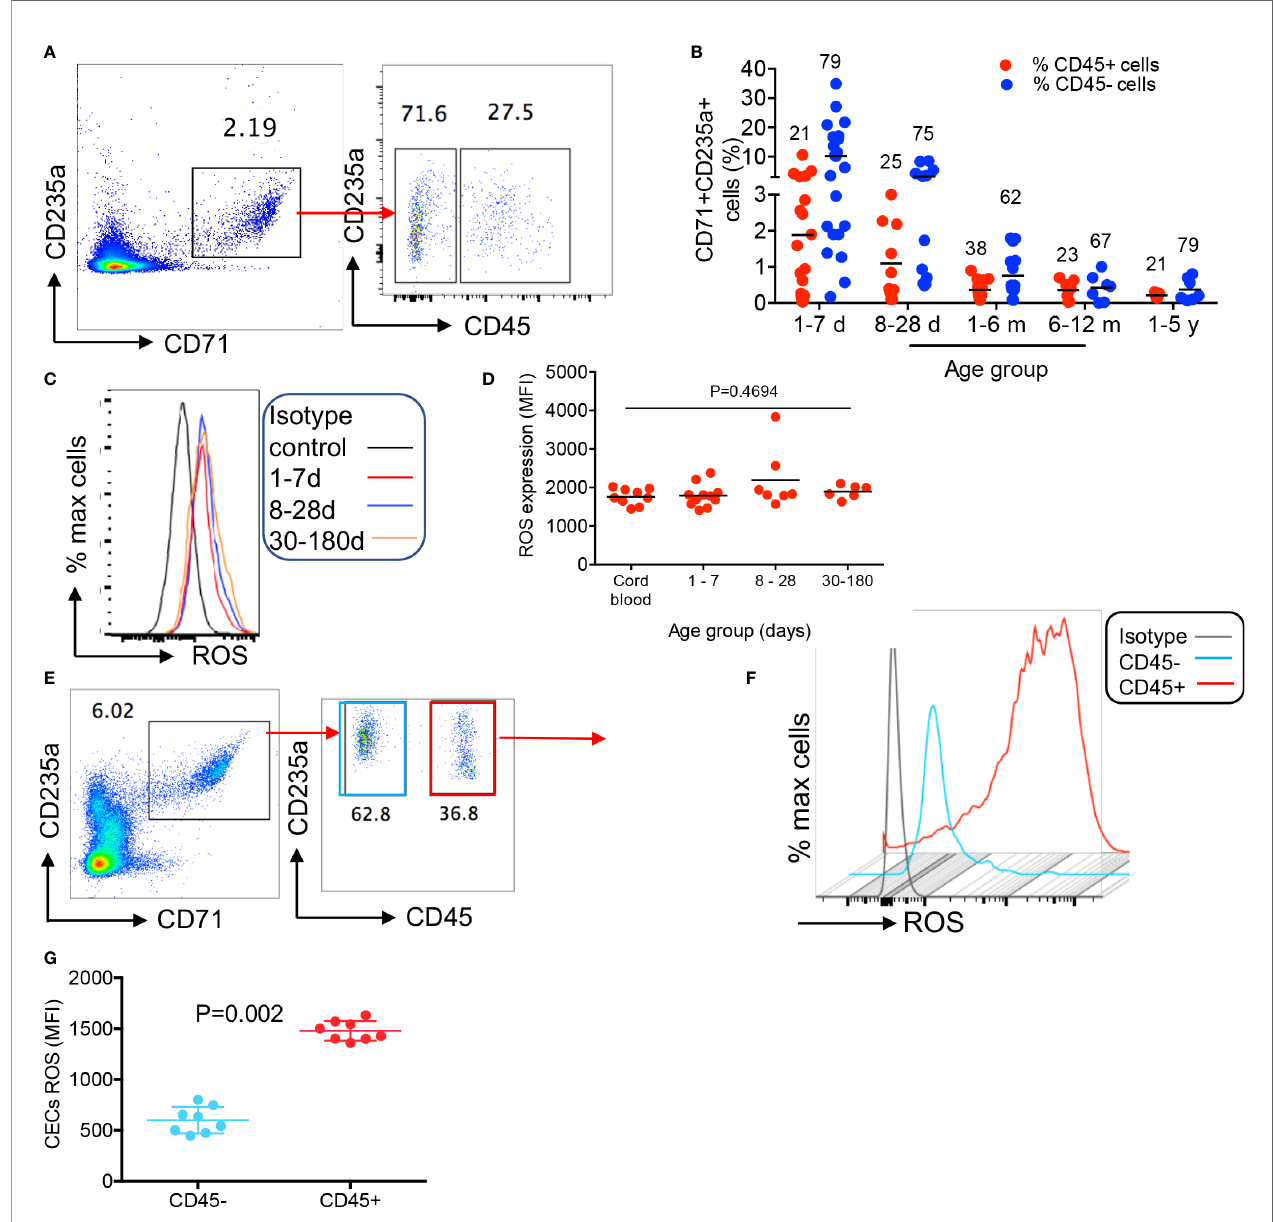
FIGURE 2 | Differential expression of ROS by CD45 + versus CD45 − CECs in humans. (A) Representative plot showing differential expression of CD45 in CECs from a human infant. (B) Cumulative data showing percentages of CD45 + and CD45 − CECs in human infants/children from day-1 to 5 years of age. The numbers on red and blue symbols showing % CD45 + or CD45 − CECs. (C) Representative histogram of ROS expression in CECs, and (D) cumulative data showing mean fl uorescence intensity (MFI) of ROS in CECs from human cord blood and neonatal blood at shown ages. (E) Representative plots showing frequency of CD45 + versus CD45 − CECs in the peripheral blood of an 8-day-old human newborn. (F) Representative histogram of ROS expression in CD45 + versus CD45 − CECs in an 8- day-old human newborn. (G) Cumulative data showing mean fl uorescence intensity (MFI) of ROS in CD45 + /CD45 − CECs of human